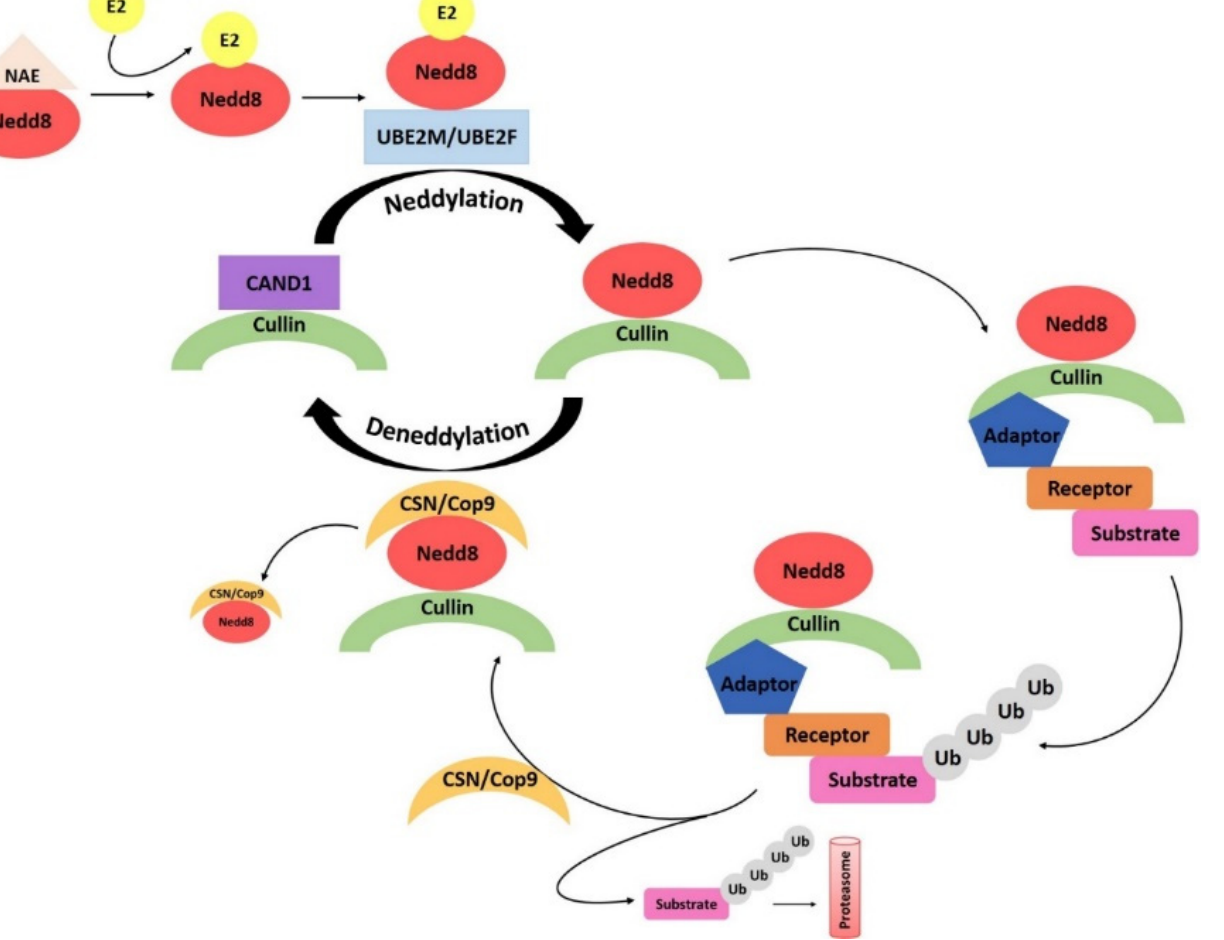
Figure 16. Steps in the Neddylation cycle: 1. Activation of Nedd8 by NAE, 2. Loading of Nedd8 to E2 UBE2M or UBE2F, 3. Displacement of CAND1 protein from Cullin Ring by Nedd8, 4. Neddylation of Cullin ring, 5. Assembly of Cullin Ring Ligase (CRL) with adaptor and substrate receptor, 6. Ubiquitination of target substrate, 7. CSN (Cop9 signalosome) binding to Nedd8, 8. Deneddylation, 9. Disassembly of CRL, 10. CAND1 binding to CRL. Table 6. Main Reactome Pathways overrepresented by ubiquitin E3 ligase adaptor genes depicted in Figure 15.